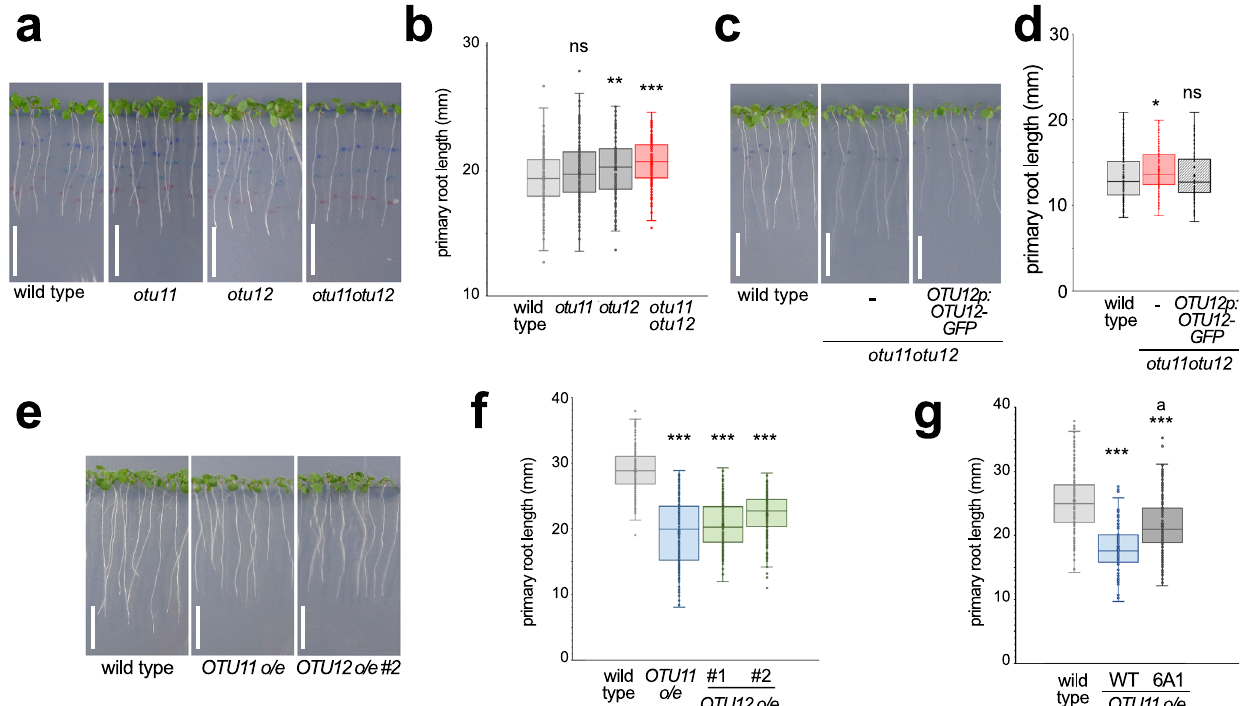
Fig. 3 | Phenotypes of otu11otu12 knock-out and OTU11 - and OTU12 over- expressing seedlings. a Photographs of 7-day-old wild-type, otu11 , otu12 , and otu11otu12 seedlings. Scale bars: 1cm. b Boxplots of primary root length of 7-day- oldwild-type( n =158seedlings), otu11 ( n =159seedlings), otu12 ( n =160seedlings), and otu11otu12 ( n =160 seedlings). Center line, median; box limits, fi rst and third quartiles; whiskers, 1.5x interquartile range; points, outliers. Wild-type/ otu11 P =0.0723 (ns: not signi fi cant), wild-type/ otu12 P =0.00417 (**0.001< P < 0.01), wild-type/ otu11otu12 P =3.28×10 − 7 (*** P <0.001), two-tailed t test, no equal var- iance. Theexperiment was conductedthree times,and one representative result is shown. c Photographsof7-day-oldwild-type, otu11otu12 ,and otu11otu12